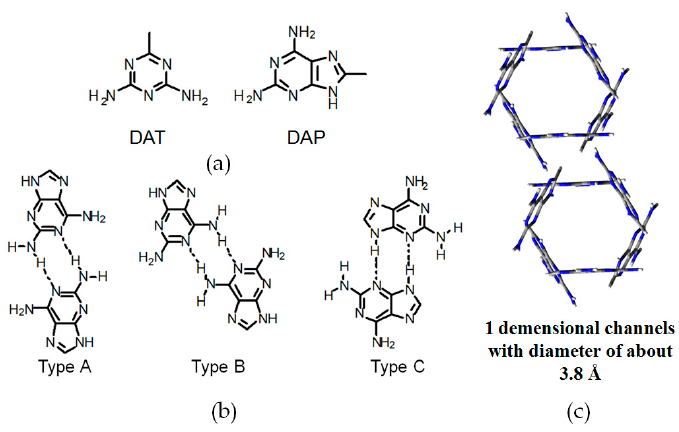
Figure 30. ( a ) Structures of DAT and DAP; ( b ) Potential hydrogen bonding patterns between DAP–DAP interactions; ( c ) Crystalline porous network of H33c grown from C 6 H 5 OCH 3